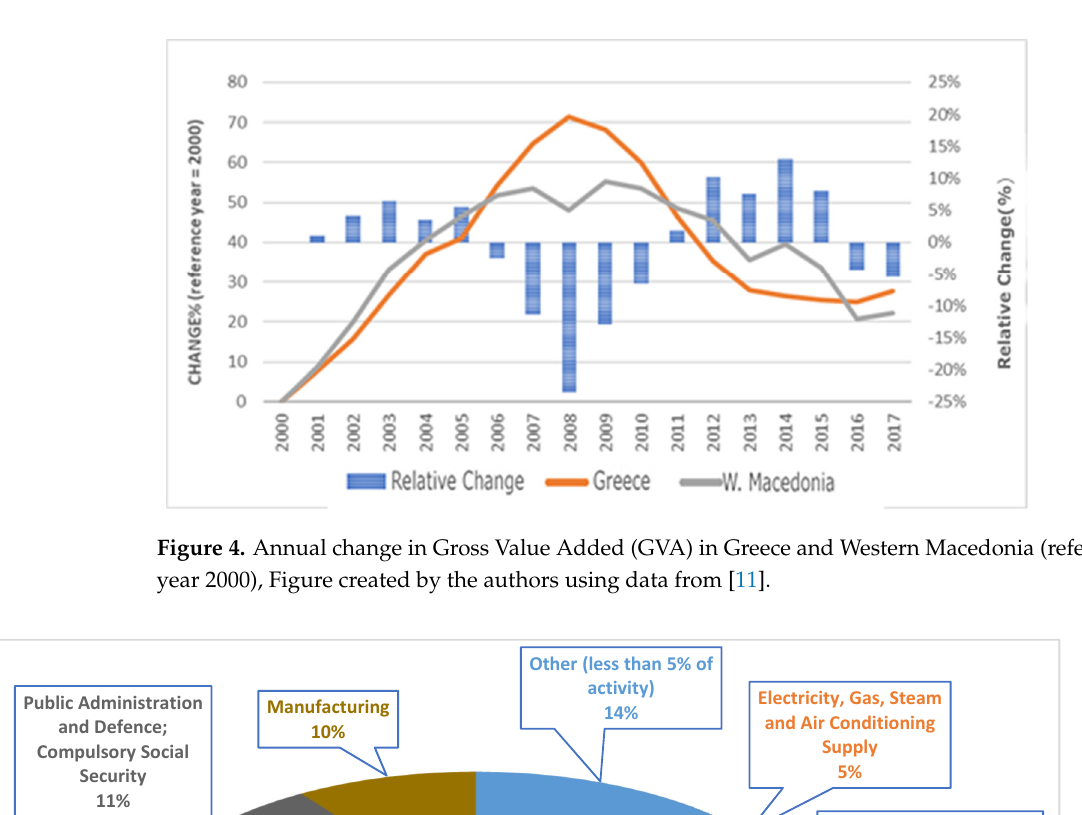
Figure 4. Annual change in Gross Value Added (GVA) in Greece and Western Macedonia (reference year 2000), Figure created by the authors using data from [11].